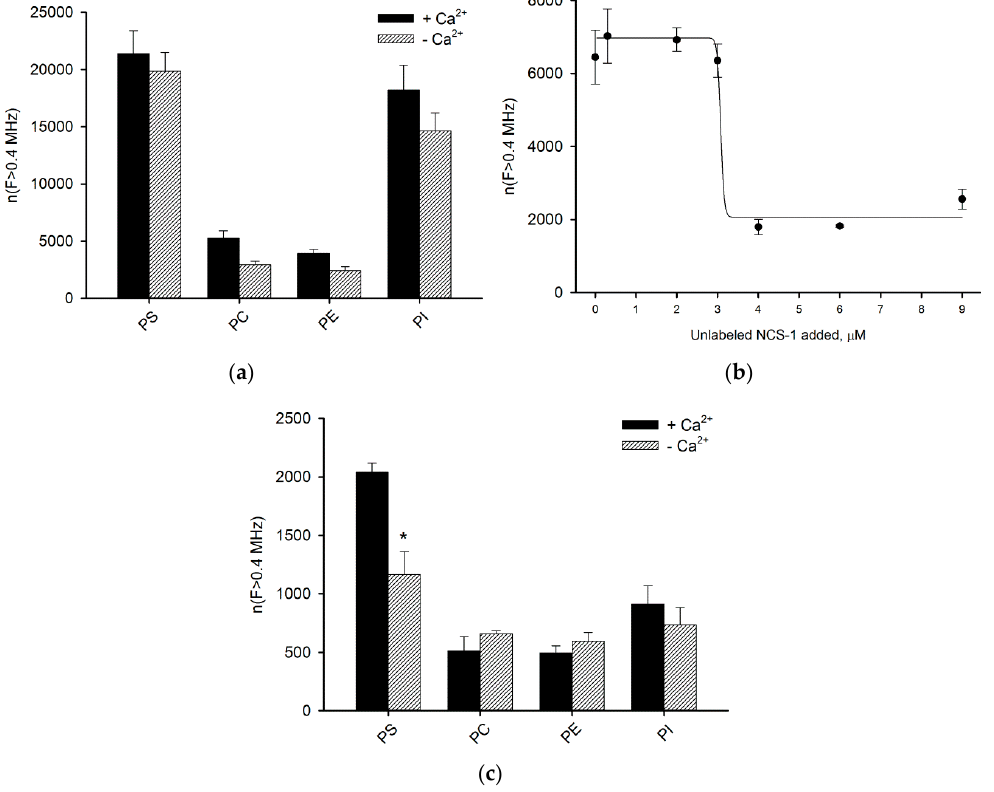
Figure 2. Binding of sulfo-cyanine-3-NCS-1 to multilamellar liposomes prepared from major cellular phospholipids, assessed by fluorescence correlation spectroscopy (FCS). ( a ) Binding efficiency of myristoylated NCS-1 to liposomes is represented by the total count of high-intensity FCS peaks exceeding 0.4 MHz threshold. ( b ) Titration of phosphatidylinositol (PI) liposomes carrying Ca 2+ -bound myristoylated NCS-1 with increasing concentrations of unlabeled NCS-1. ( c ) Binding efficiency of unmyristoylated NCS-1 to liposomes. * p < 0.05 as compared to binding of unmyristoylated NCS-1 to phosphatidylserine (PS) in the presence of Ca 2 +